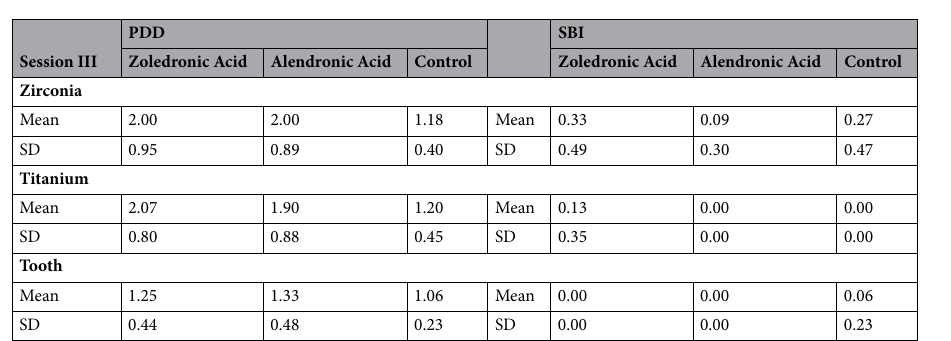
Table 2. Clinical parameters at session III (12 weeks after surgery) included the pocket probing depth (PPD) and the sulcus bleeding index (SBI) around each implant or tooth (PDD = pocket probing depth, SBI = sulcus bleeding index, SD = standard